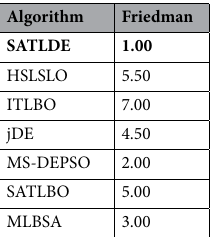
Table 4. Results of Friedman test for the ten-reservoir problems. Significant values are in bold.